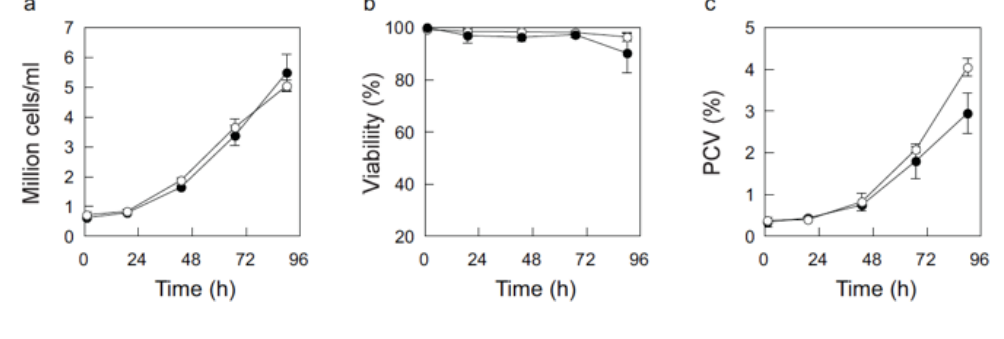
250-mL Erlenmeyer flasks (open circles) and 250-mL HT tubes (closed circles) at a density of 0.6 × 10 6 cells/mL and incubated at 28 °C with agitation at 130 rpm for the Erlenmeyer flasks and 140 rpm for the HT tubes. The working volumes were 50 mL in the Erlenmeyer flasks and 100 mL in the HT tubes. At the times indicated, the ( a ) viable cell density, ( b ) viability, and ( c ) biomass were measured. The experiment was performed in duplicate. Error bars represent